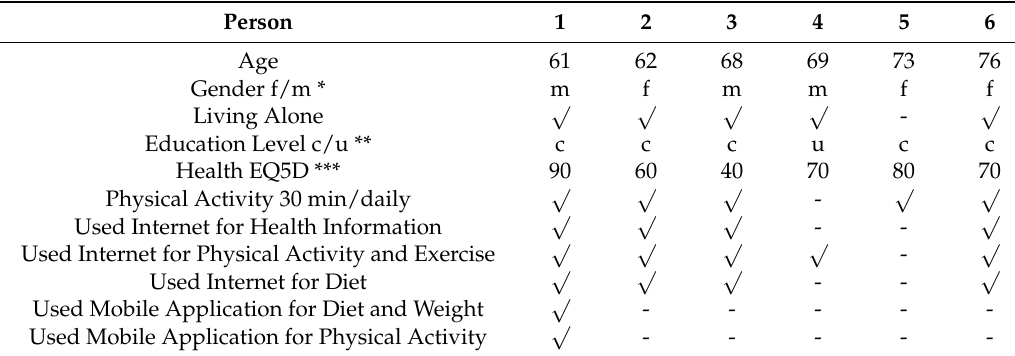
Table 1. Characteristics of the